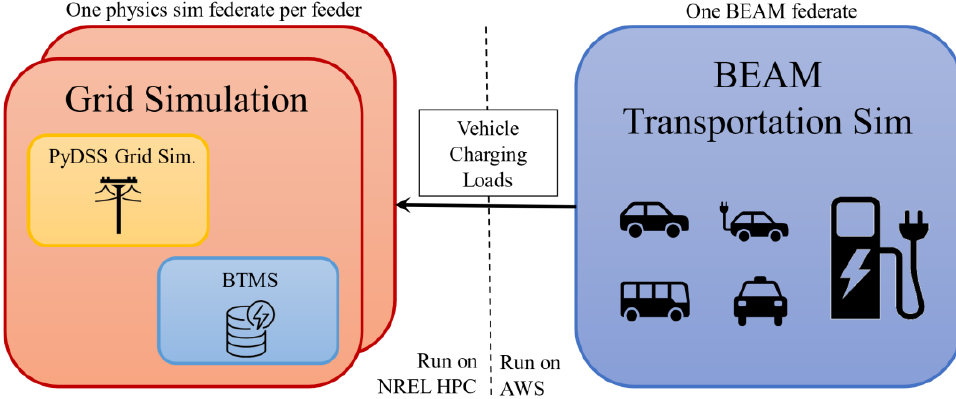
Figure 1. Block diagram of co-simulation framework without smart charging.